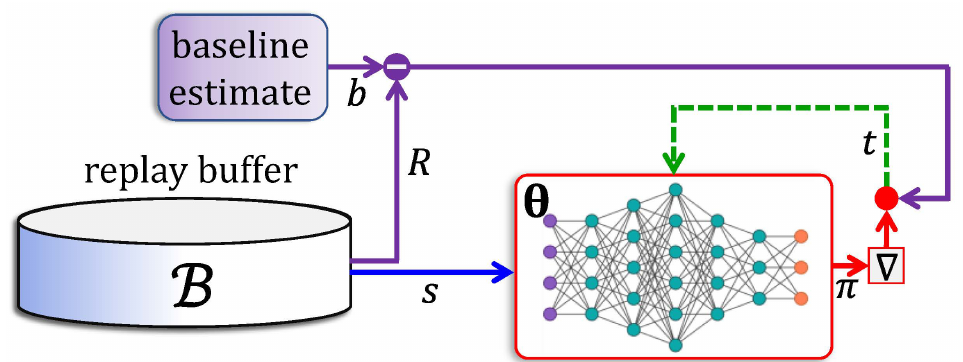
Figure 9. Policy Gradient with Baseline. Shown is the overall scheme used in REINFORCE with the baseline. There are different ways to implement the